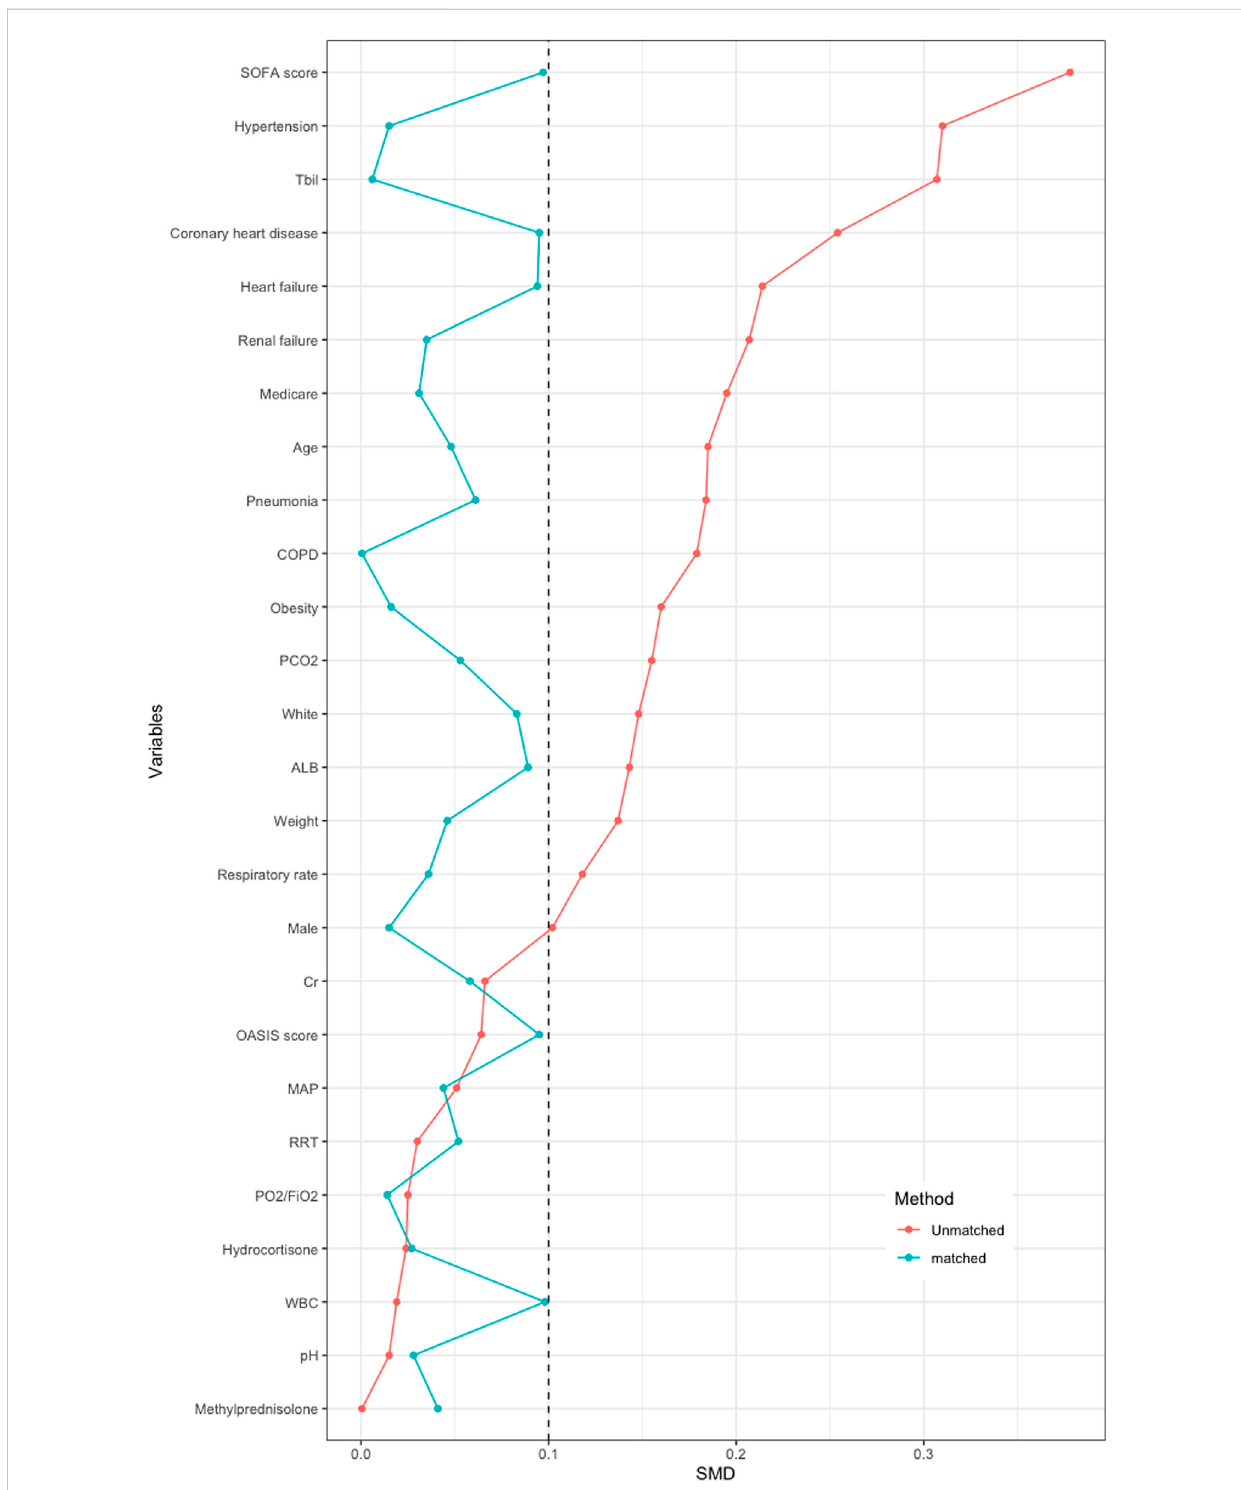
FIGURE 2 Pre- and post-propensity score matching the difference of baseline characteristics between the two groups.